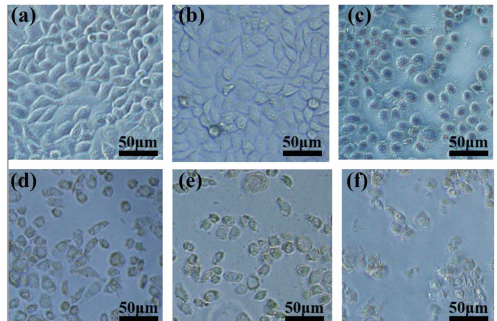
Figure 12. ( a ) Control group without sample and RT; ( b ) FPO@HMSNs-PAA (0 µ g · mL − 1 ) + RT (55 kV, 8 mA); ( c ) FPO@HMSNs-PAA (8 µ g · mL − 1 ) + RT (55 kV, 8 mA); ( d ) FPO@HMSNs-PAA (16 µ g · mL − 1 ) + RT (55 kV, 8 mA); and, ( e ) FPO@HMSNs-PAA (32 µ g · mL − 1 ) + RT (55 kV, 8 mA); ( f ) FPO@HMSNs-PAA (40 µ g · mL − 1 ) + RT (55 kV, 8